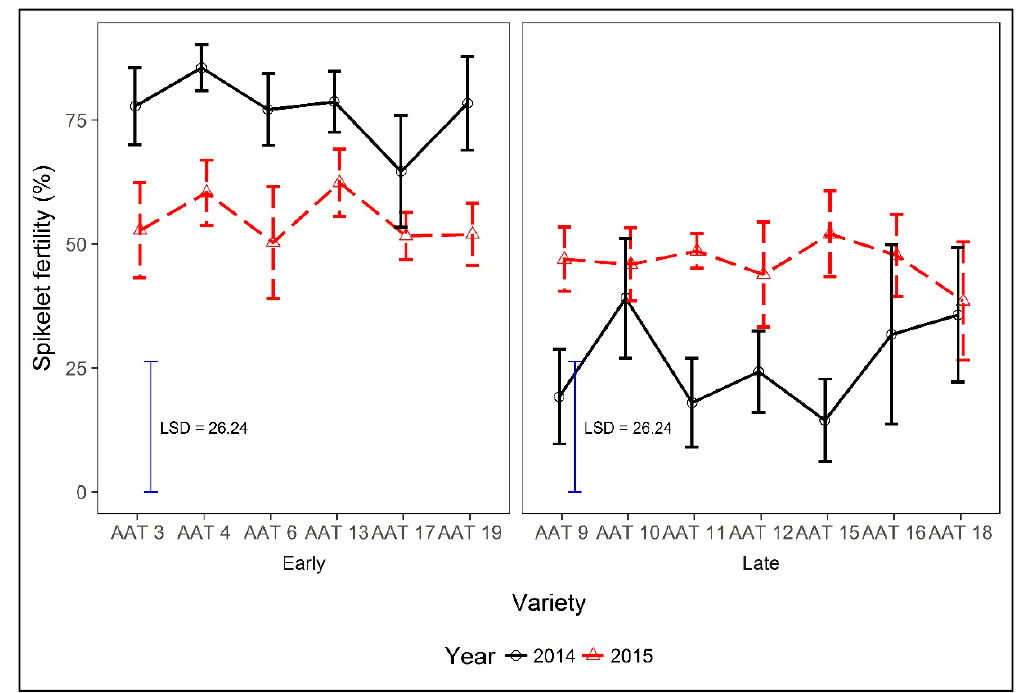
Figure 5. Spikelet fertility percentage of rice varieties, by maturity class, in years 2014 and 2015. LSD for comparisons of the variety by year interaction.